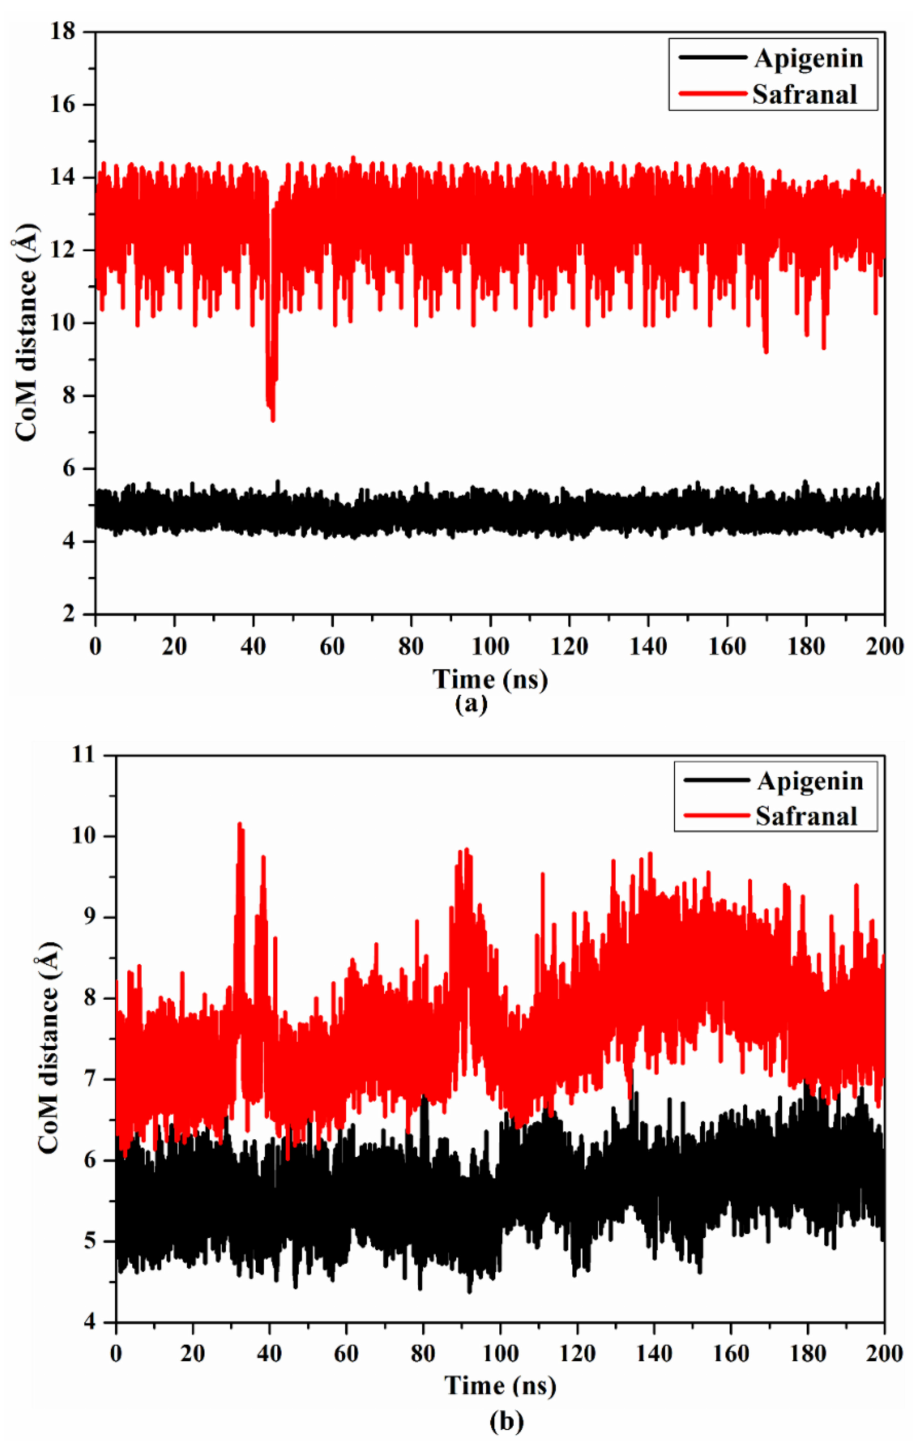
Figure 8. CoM distances (in Å) between apigenin and safranal and ( a ) VAL156 of the 5HT2AR as well as ( b ) VAL117 of the 5HT1AR during 200 ns MD